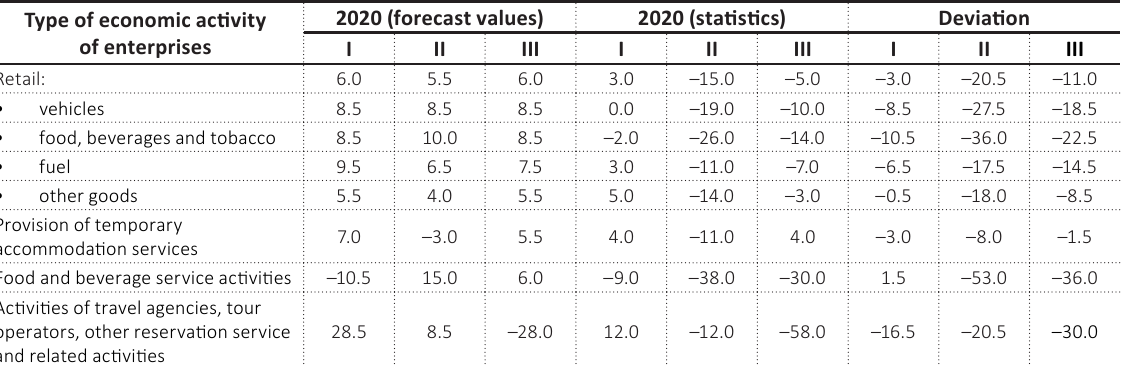
Table 6. Comparison of expected changes in the number of employed in retail trade, hotel and restaurant and tourism business according to the 2016–2019 trend analysis and in connection with the lockdown in 2020 (% of the total number of enterprises) Source: Compiled by the authors according to the State Statistics Service of Ukraine